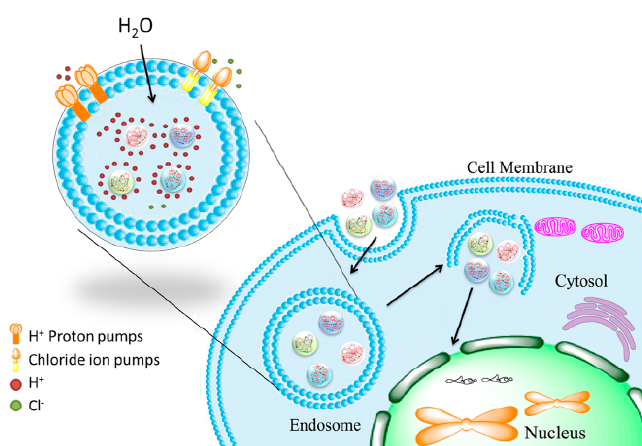
Figure 13. Schematic illustration of endosomal escape promoted by histidine-enriched multifunctional peptide gene vectors. Adapted from [163], with permission. Copyright: 2013 Royal Society of Chemistry.